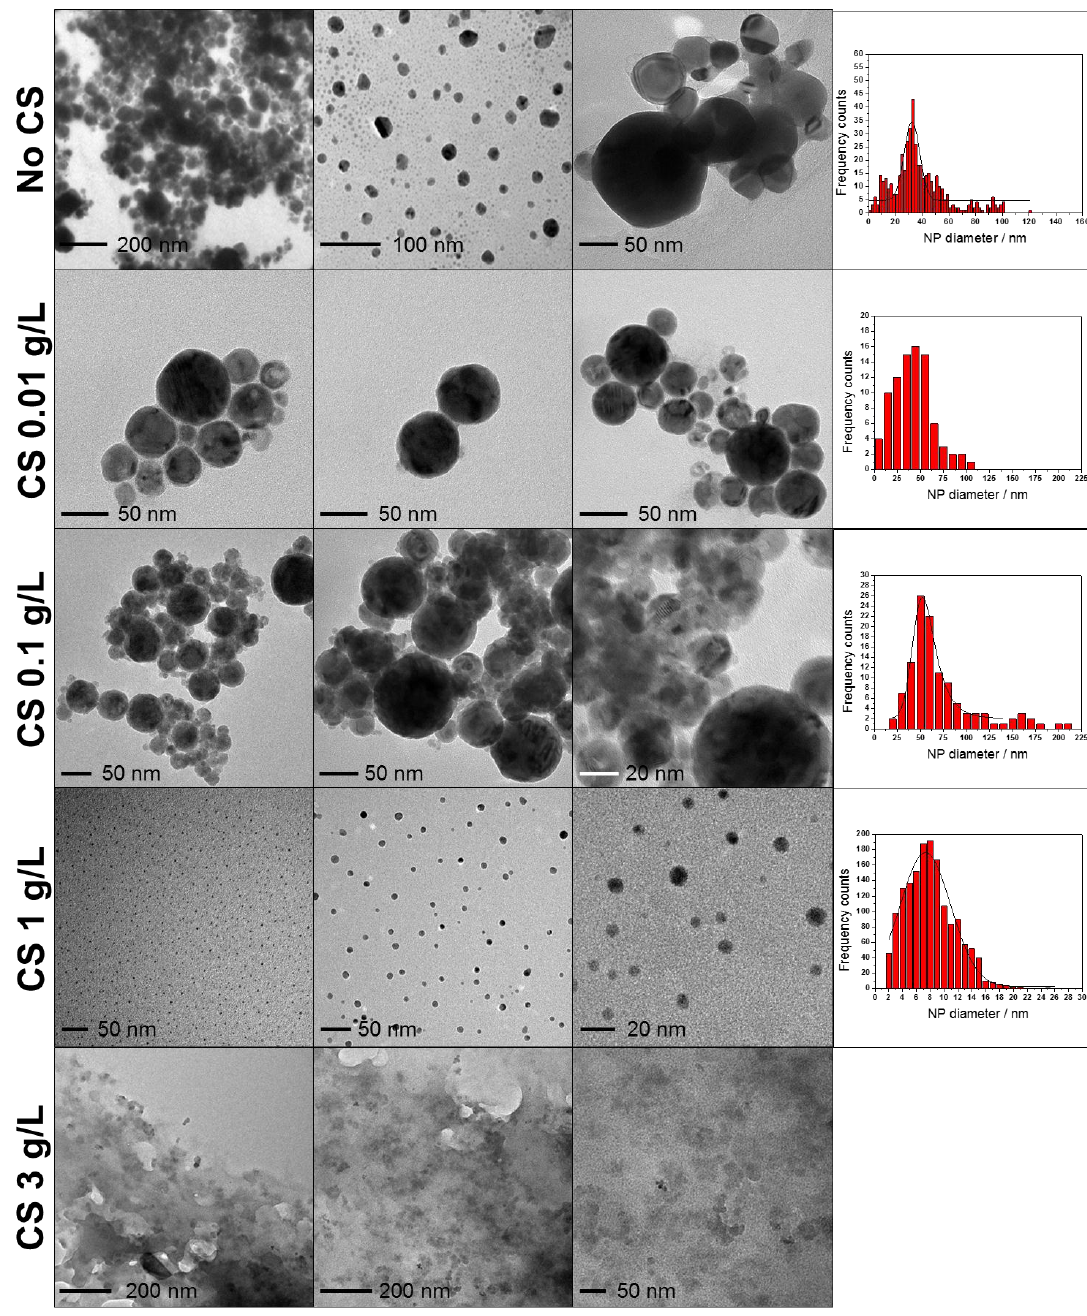
Figure 1. Transmission electron microscopy (TEM) images of laser-generated Cu nanoparticles (CuNPs) in the presence of different chitosan (CS) concentrations and corresponding size distribution histograms. Sizing could not be performed on 3 g/L CuNPs-CS nanocomposite, because of the massive presence of organic matrix.